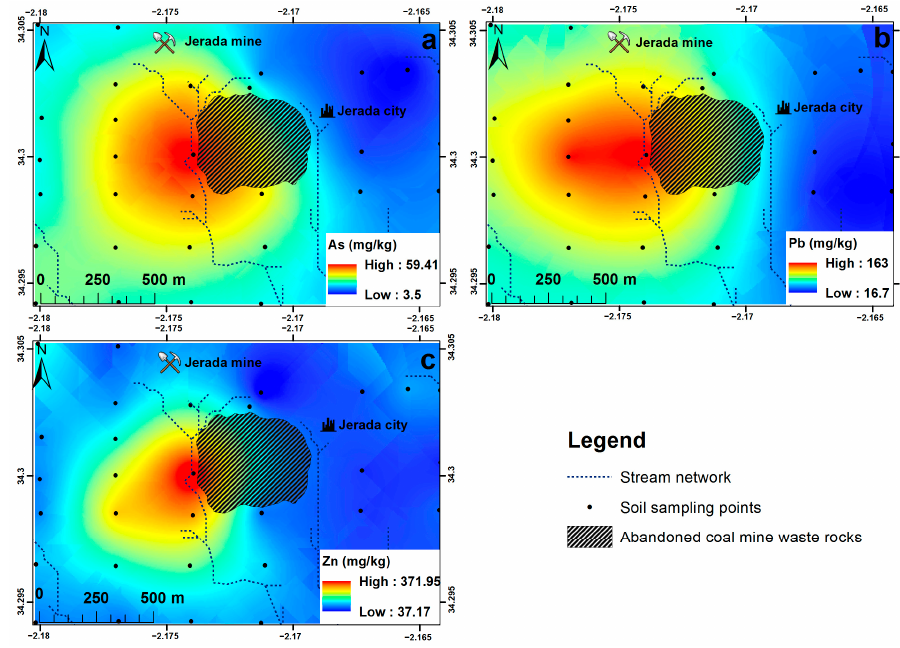
Figure 7. Geochemical map of the selected trace elements .